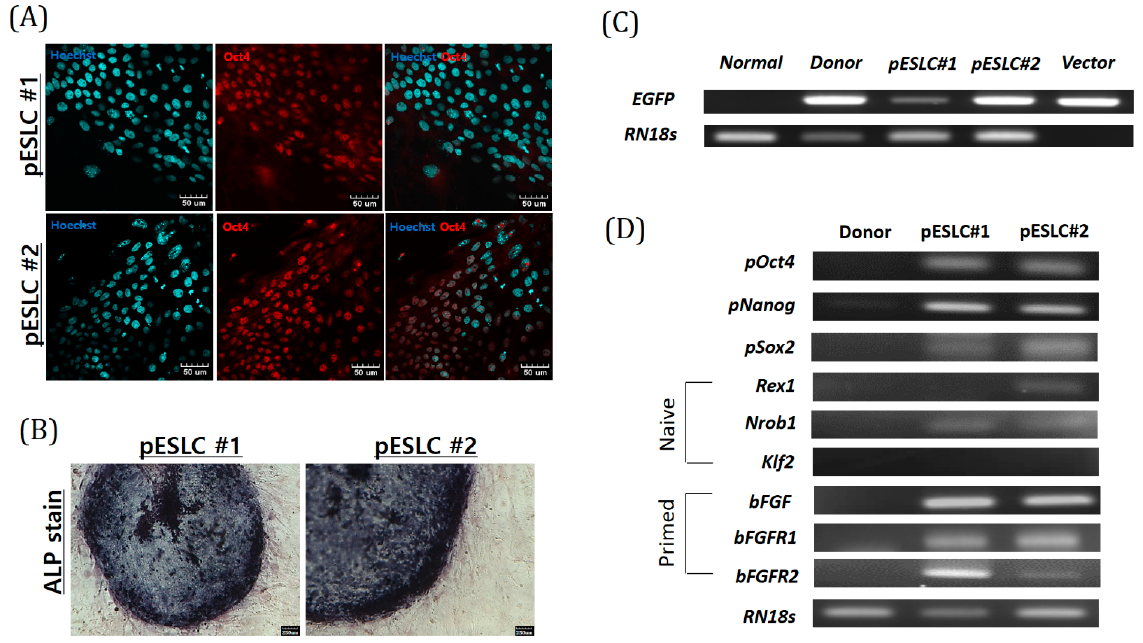
Figure 3. Characterization of Yucatan EGFP pESLC lines . ( A ) The expression of pluripotent marker (Oct4) in Yucatan EGFP pESLC lines as assessed by immunofluorescence analysis; scale bars = 30 mm. ( B ) Alkaline phosphatase (ALP) stain; scale bars = 100 mm. ( C ) Identification of transgenes in genomic DNA from the Yucatan EGFP pESLC lines by polymerase chain reaction (PCR). RN18s was used as a control. ( D ) The expression of pluripotent marker genes (undifferentiated pluripotent cell marker: pOct4, pNanog , and pSox2 ; naive markers: Rex1, Nrob1, and Klf2 ; and primed markers: bFGF , bFGFR1 , and bFGFR2 ) in Yucatan EGFP pESLCs.